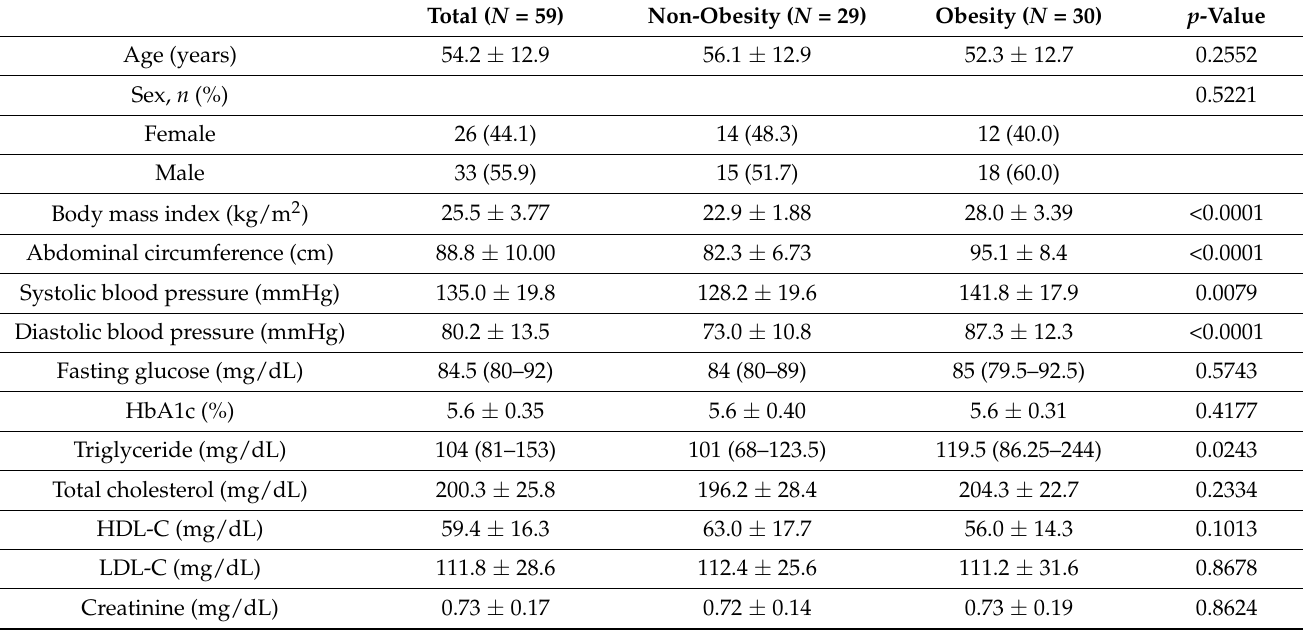
Table 1. Characteristics of study participants grouped according to the absence or presence of obesity.